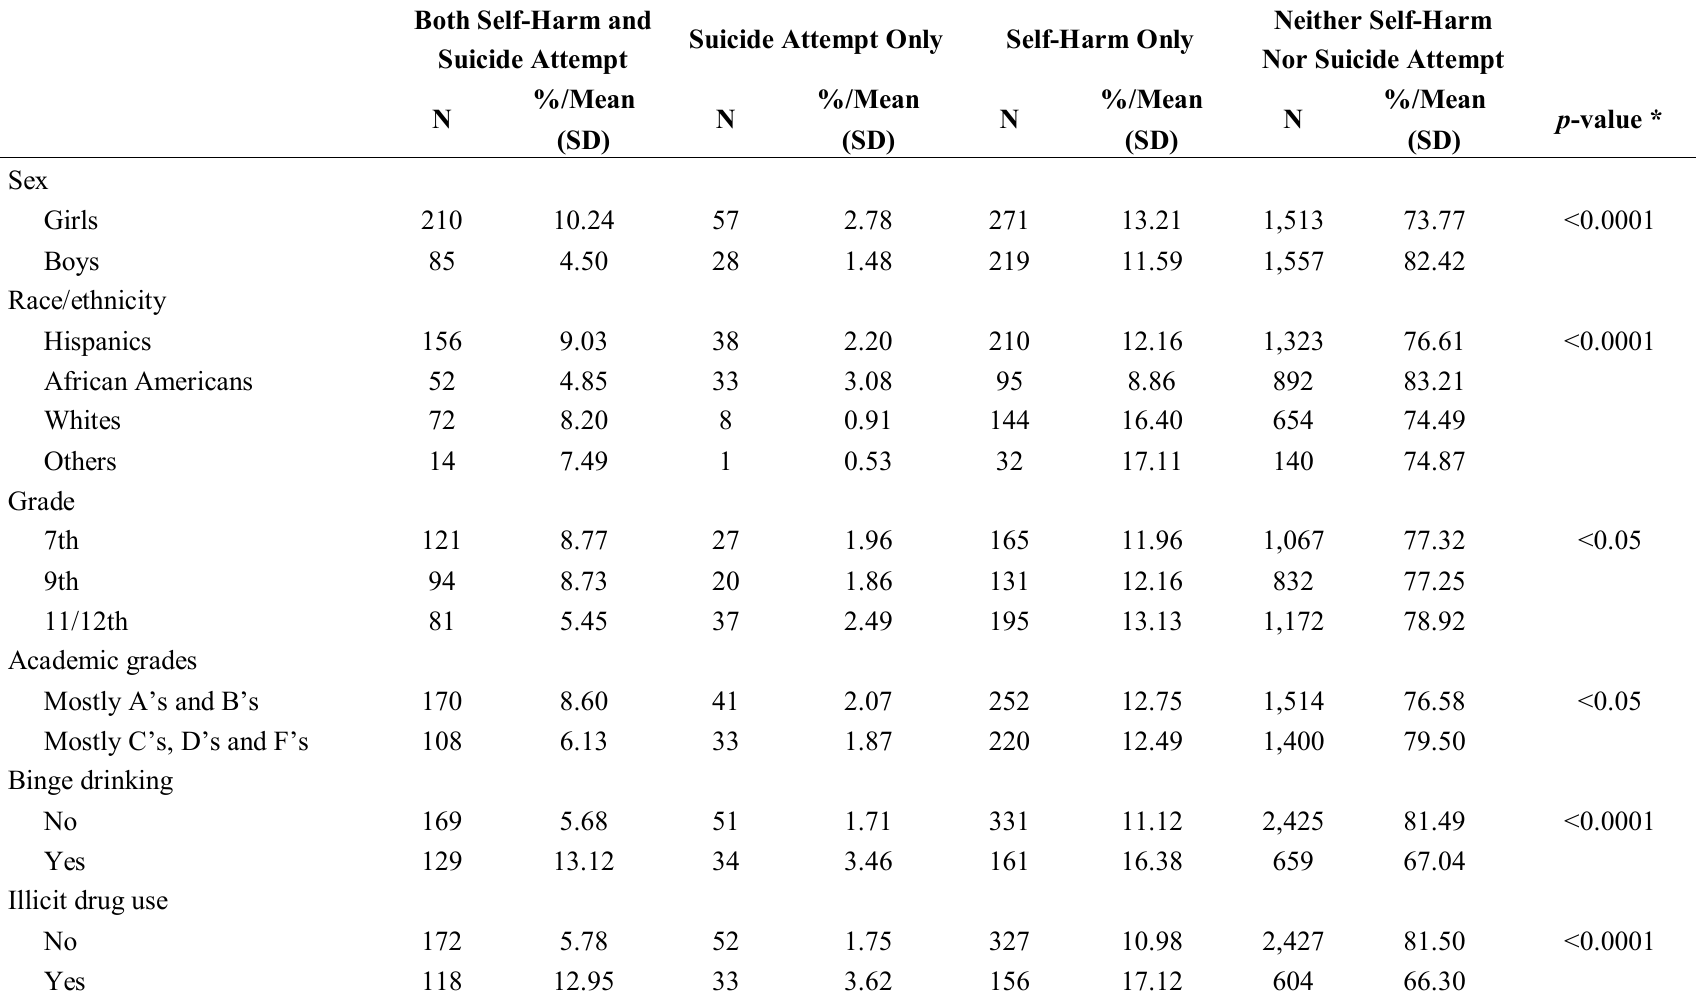
Table 1. Demographic and psychosocial characteristics associated with self-harm or suicide attempts among high-risk urban youth in the U.S. Both Self-Harm